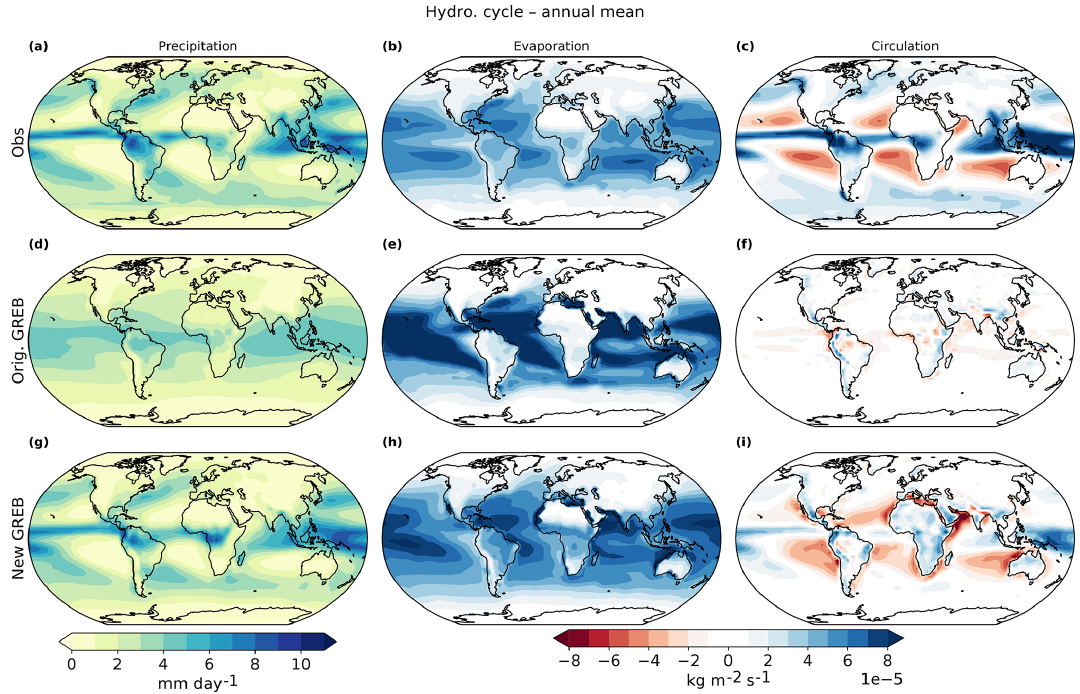
Figure 2. The decomposition of the hydrological cycle into its parts: precipitation in mmday − 1 (a, d, g) , evaporation (b, e, h) and circulation in kgm − 2 s − 1 (c, f, i) in observations (a, b, c) , the original GREB model (d, e, f) and the new GREB model (g, h, i) for the annual mean.